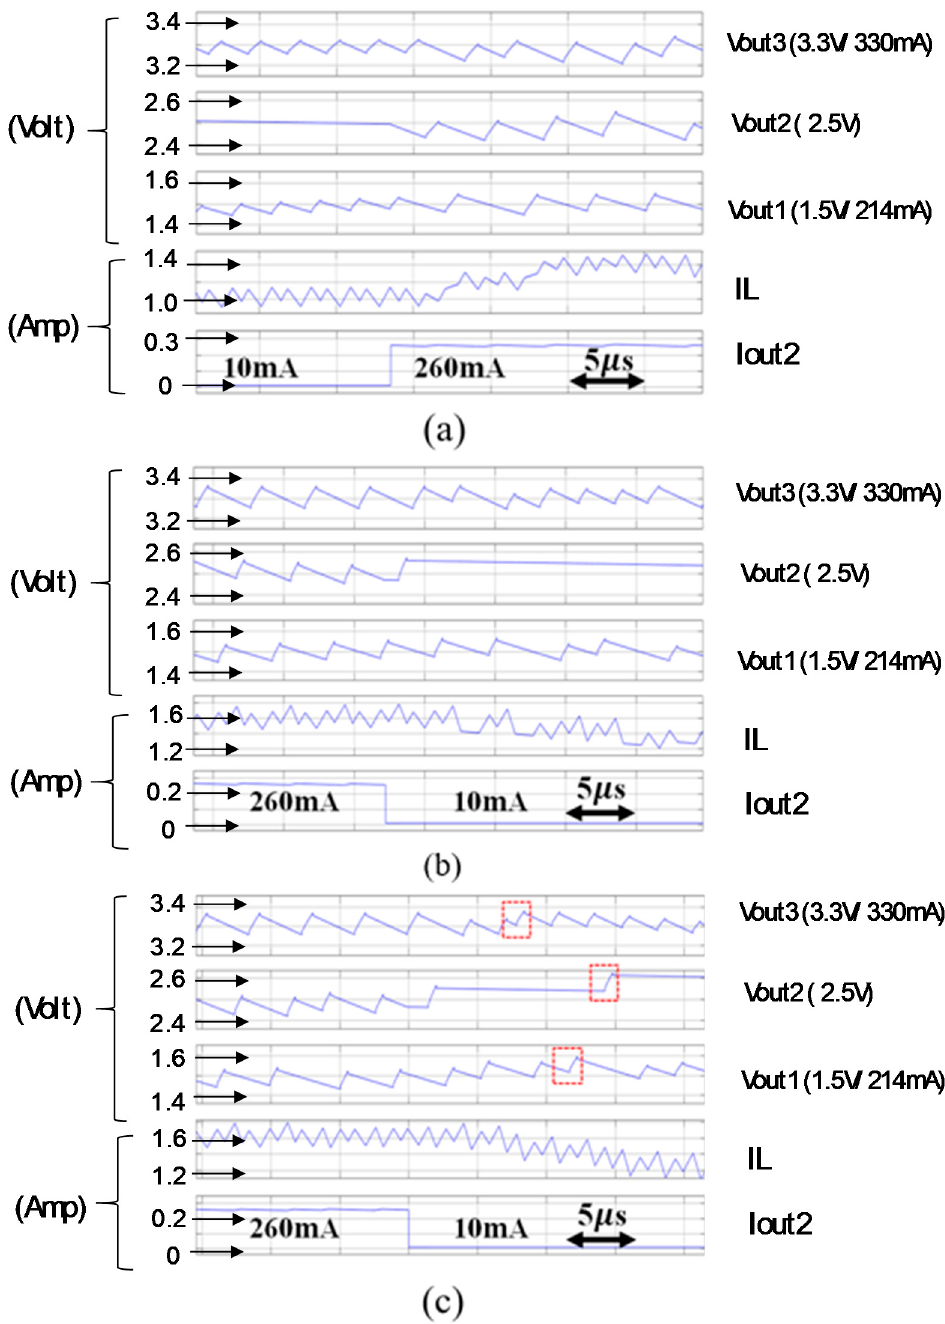
Figure 8. Simulated transient waveforms of the proposed EDRC ( a ) under a positive step change of load current in output 2 from 10 to 260 mA and ( b ) under a negative step change of load current in output 2 from 260 to 10 mA. ( c ) Simulated transient waveforms of the EDRC without adopting the no demand no selection (NDNS) technique under a negative step change of load current in output 2 from 260 to 10 mA. The dashed boxes show when power supply exceeded demand.